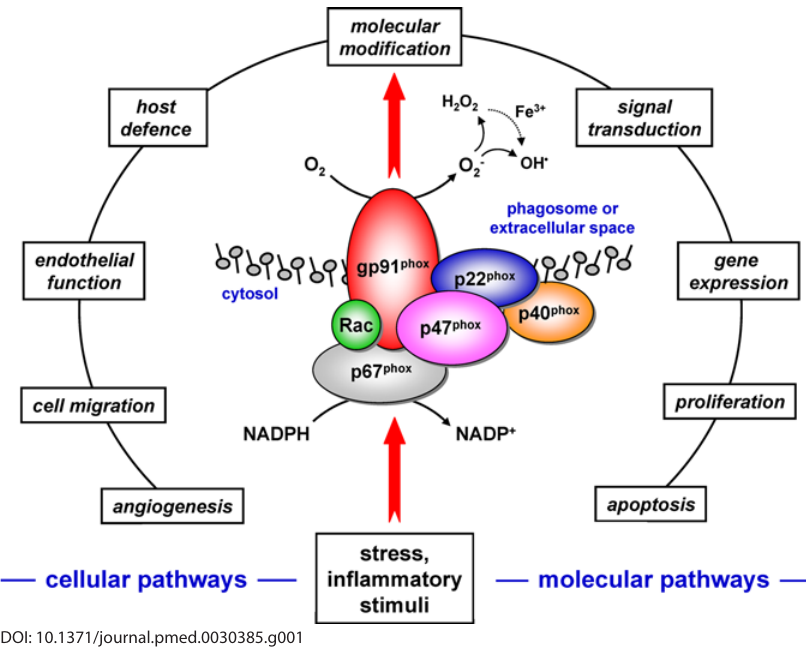
Figure 1. Structure and Function of the NADPH Oxidase Complex Schematic of the molecular composition of the NADPH oxidase complex. The principal subunits are shown, together with some of the key cellular and molecular modifi cations that arise following react to generate hydroxyl radicals (OH•). Through their effects on protein modifi cation and lipid peroxidation, reactive oxygen species exert pleiotropic effects on multiple molecular and cellular